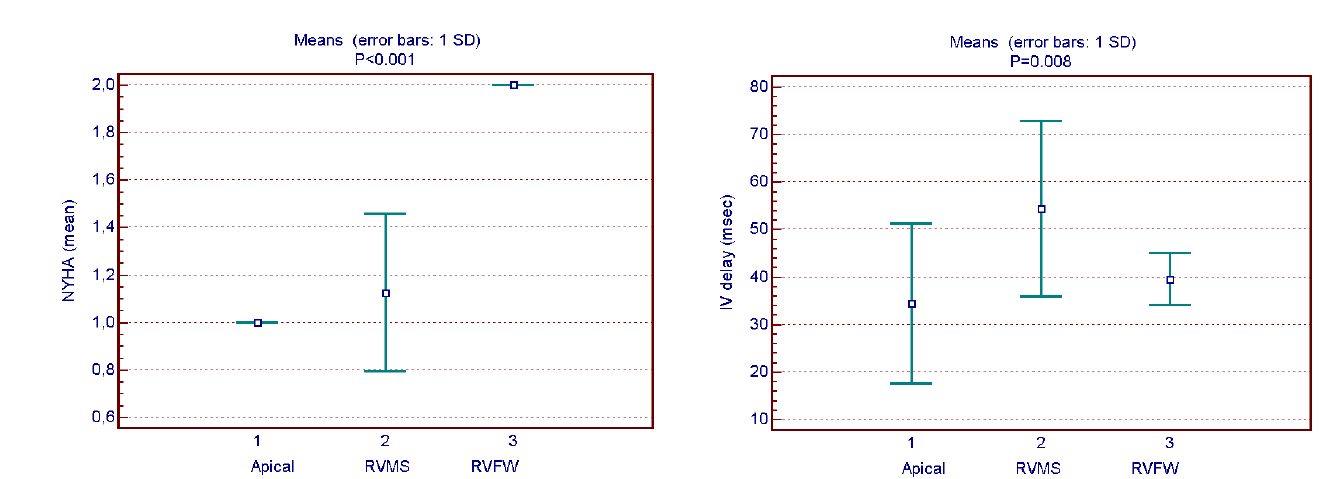
Fig. 3 - QRS duration and aortic pre-ejection time. Fig. 4 - QRS duration and interventricular delay.